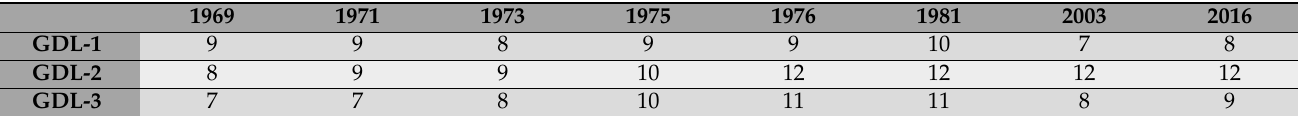
Table 2. Number of major communities in the GDL-1, 2, and 3 model